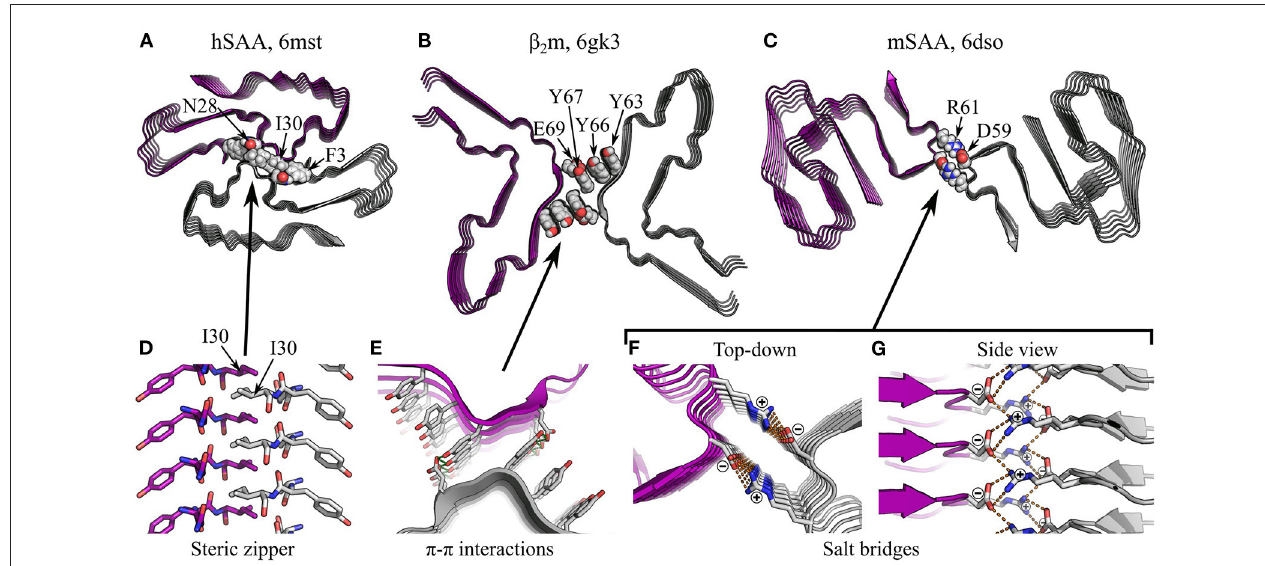
FIGURE 10 | Specific interactions in supra-protofilament assembly (part 1). (A–C) show various fibril structures with specific inter-protofilament interactions highlighted: (A) , human serum amyloid A (hSAA; Liberta et al., 2019), with an inter-protofilament steric zipper; (B) , β 2 m (Iadanza et al., 2018b), with π -stacking by tyrosines and sidechain-sidechain hydrogen bonding between Y67 and E69; (C) , murine serum amyloid A (mSAA; Liberta et al., 2019), with salt bridges between D59 and R61. The name of the polypeptide is given above each structure, alongside the PDB ID. Structures are shown as ribbon diagrams, with protofilaments colored gray or purple for discrimination. Sidechains of interest are highlighted as spheres, with the color scheme: gray, carbon/hydrogen; red, oxygen; blue, nitrogen. For (B) , missing hydrogens have been modeled in. The same scale is used throughout (A–C) , and is shared with that used in Figures 11A,B . (D–G) show close-up views of the highlighted interactions. In (E–G) , structures are shown as ribbon diagrams with sidechains as sticks, using the same color scheme as before; (D) is a side view of the steric zipper in hSAA fibrils, shown entirely as sticks and with the carbons on one protofilament colored purple. For clarity and consistency between structures, hydrogens are not represented with sticks and are thus implicit. Hydrogen bonds are represented by green dashed lines, and salt bridges in mSAA are represented by orange dashed lines. Note that the zig-zag alternation of sidechains across the interfaces in (D,G) is due to pseudo-2 1